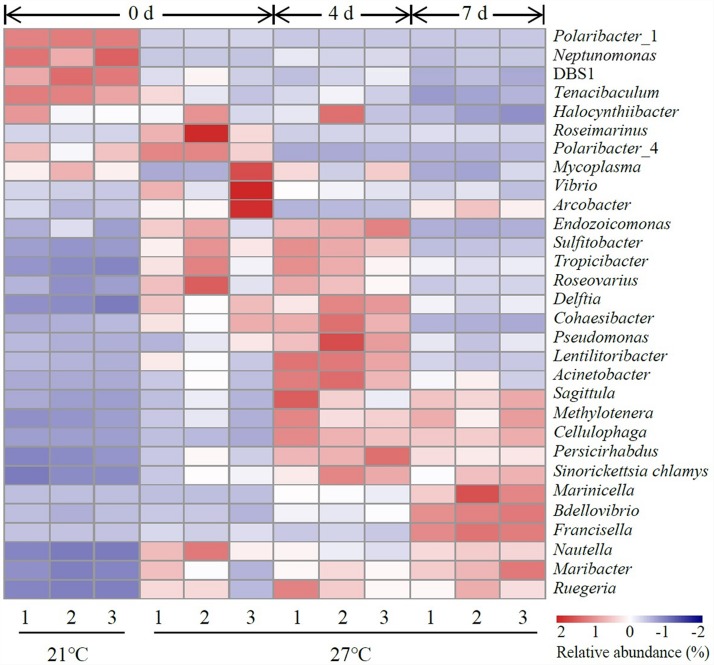
Heatmap revealing the top 30 bacterial genera (%) of gut samples. Three replicates are labeled with the numbers 1, 2, and 3.